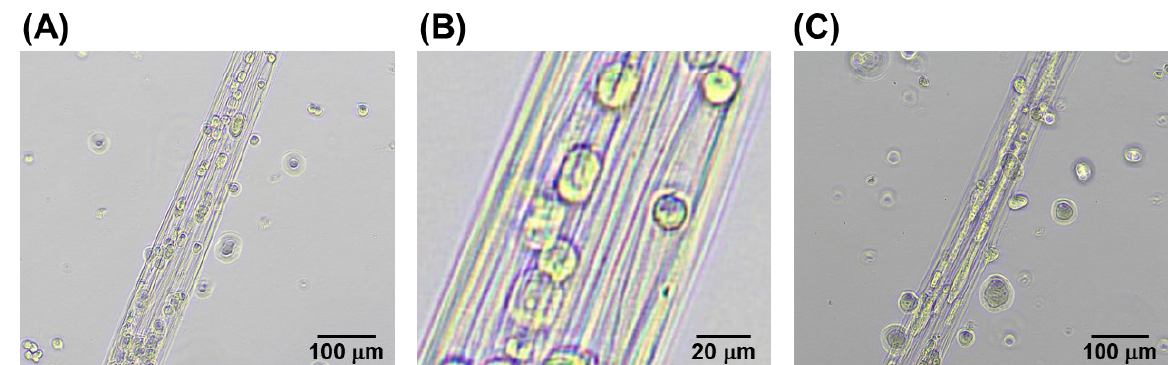
Figure 5. Cell culture in the hydrogel fibers after ( A , B ) 0 and ( C ) 2 days. ( B ) Magnified image. MCF-7 cells were incorporated into the hydrogel fibers, and these fibers were embedded in Matrigel.